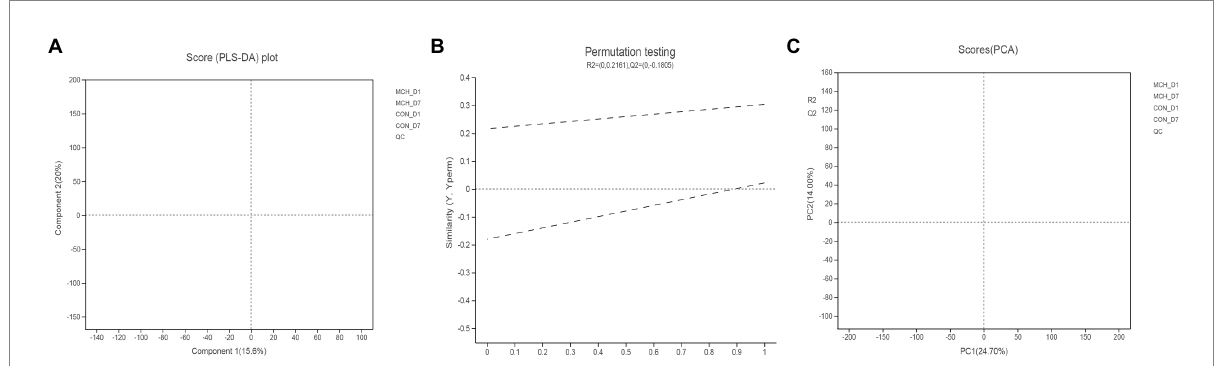
FIGURE 4 Principal component analysis score plot (A) , permutation test plot (B) and orthogonal partial least squares discriminant analysis (OPLS-DA) (C) for days 1 and 7 between MCH group and CON group based on milk metabolite profiles. The variation in the principal components is indicated on the axes. Each spot is one sample, and the days are shown as green circles for day 1 and blue triangles for day 7 ( n = 6).